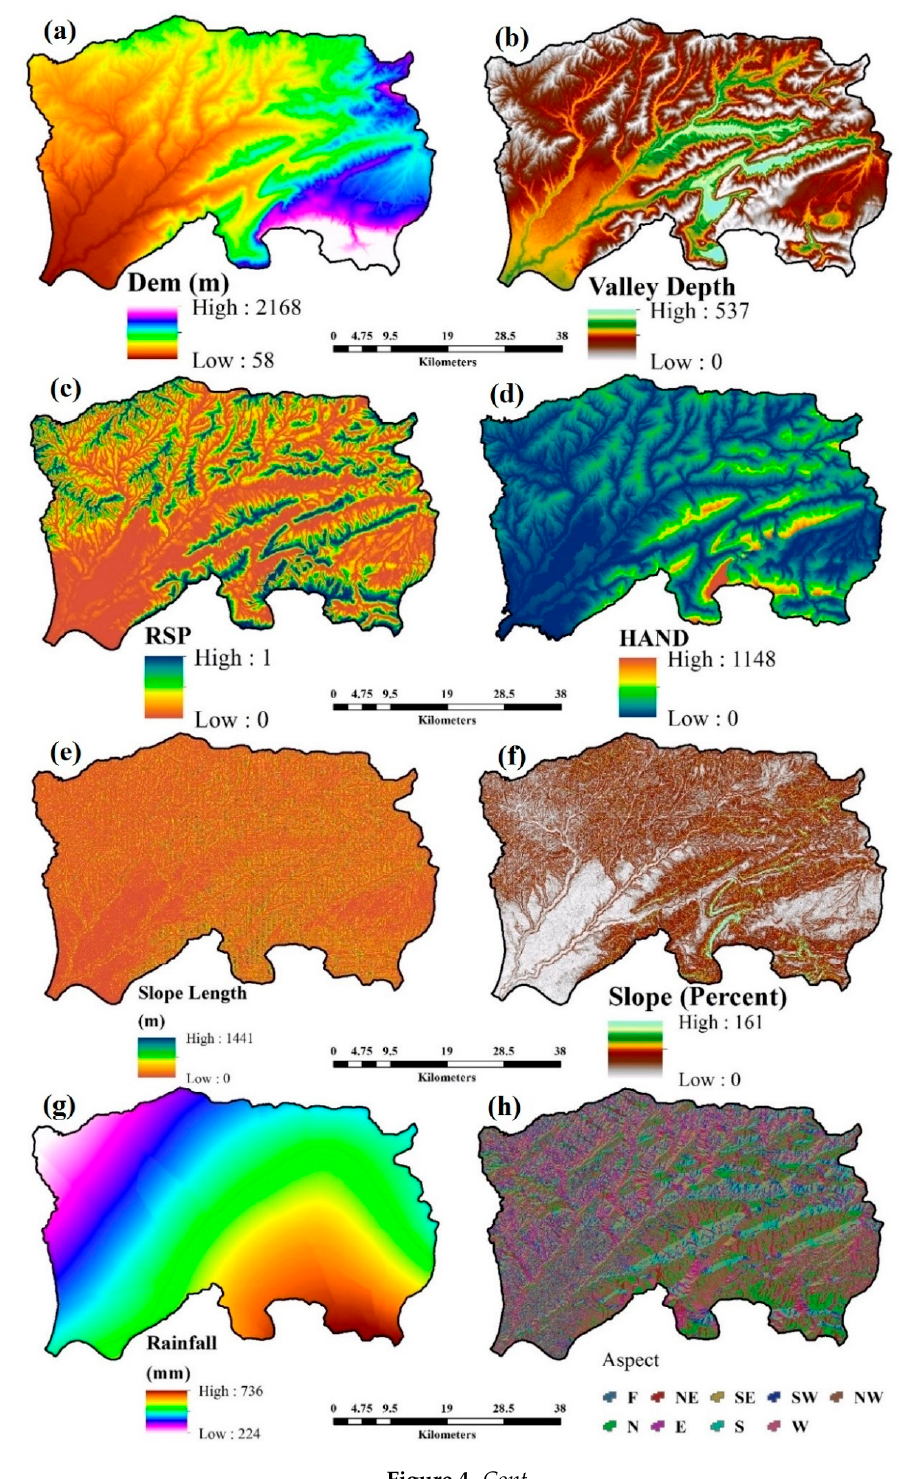
Figure 4. Conti. Figure 4.